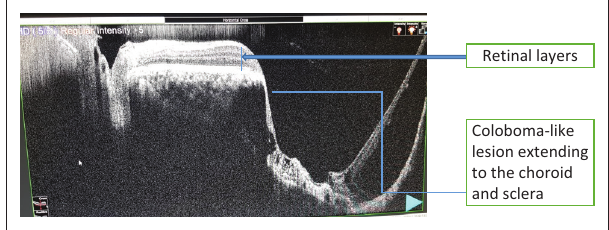
FIGURE 3: A cross-section image of an OCT showing a retinal coloboma-like lesion and a total disruption of the retinal layers extending to the choroid and sclera, with remnants of the